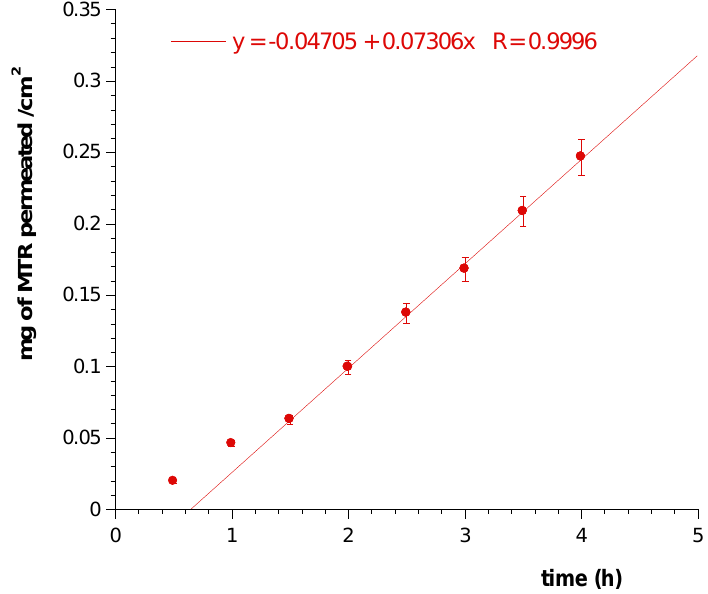
Figure 8. Linear fit at the steady state of MTR permeation per cm 2 of porcine sublingual mucosa. The residual CUR and MTR entrapped into the membrane were quantified by methanol extraction and analyzed respectively by HPLC and UV-Vis assays. After 4 h, the average amounts extracted were 0.0032 mg of CUR and e 0.0835 mg of MTR, that are respectively 6.31% and the 4.37% of the